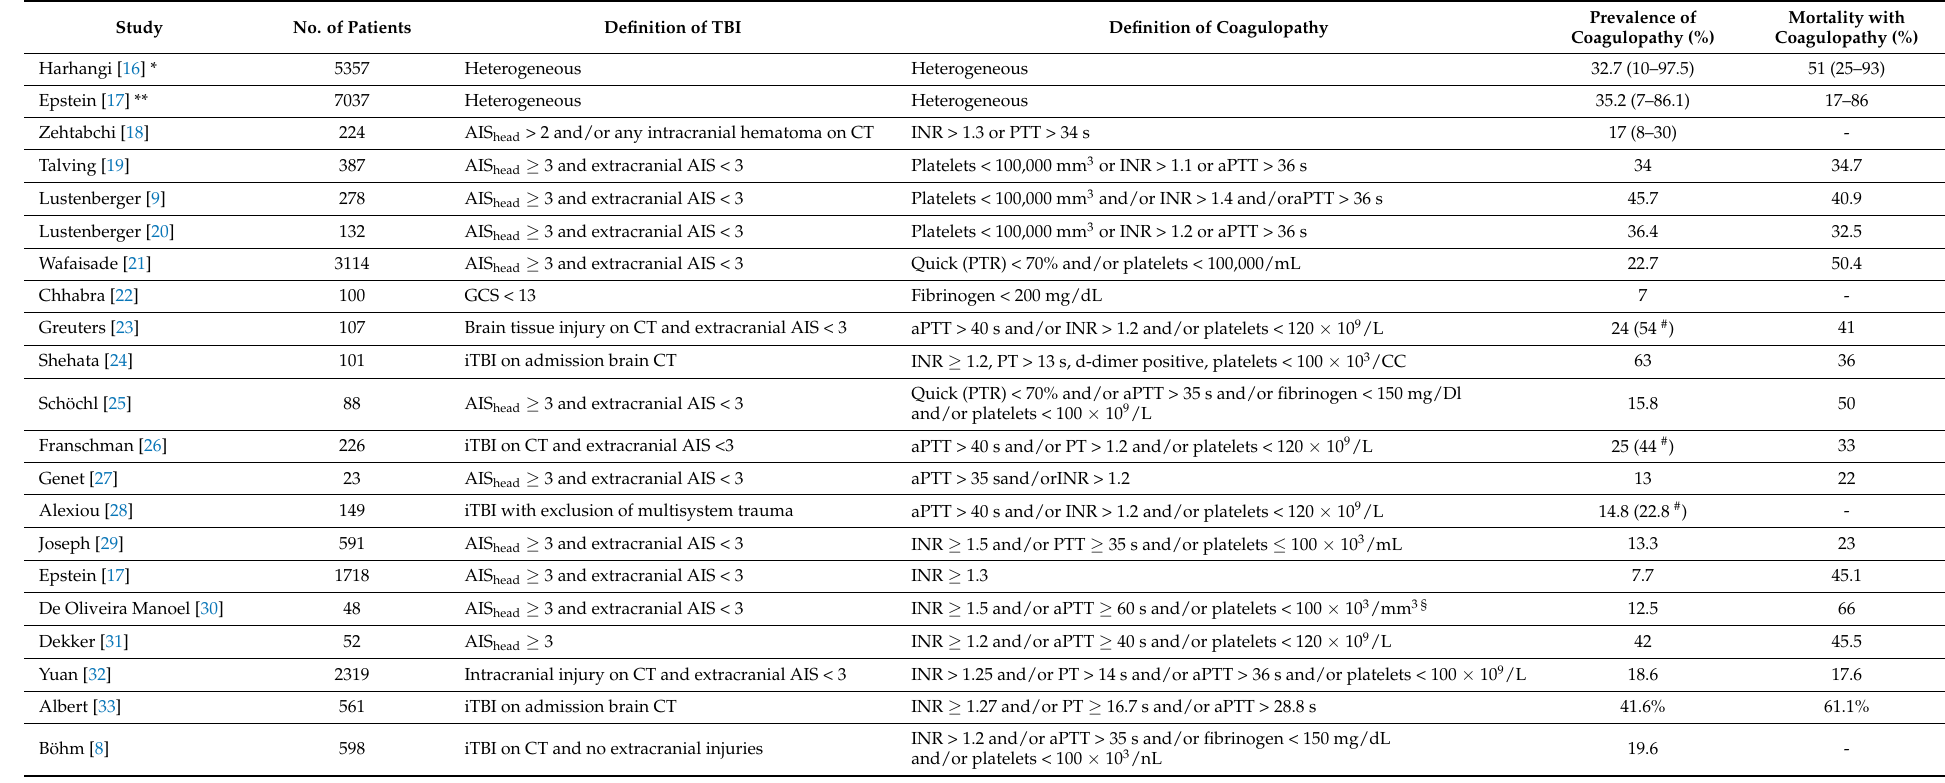
Table 1. Prevalences of coagulopathy in isolated traumatic brain injury (iTBI), including outcome in the presence of